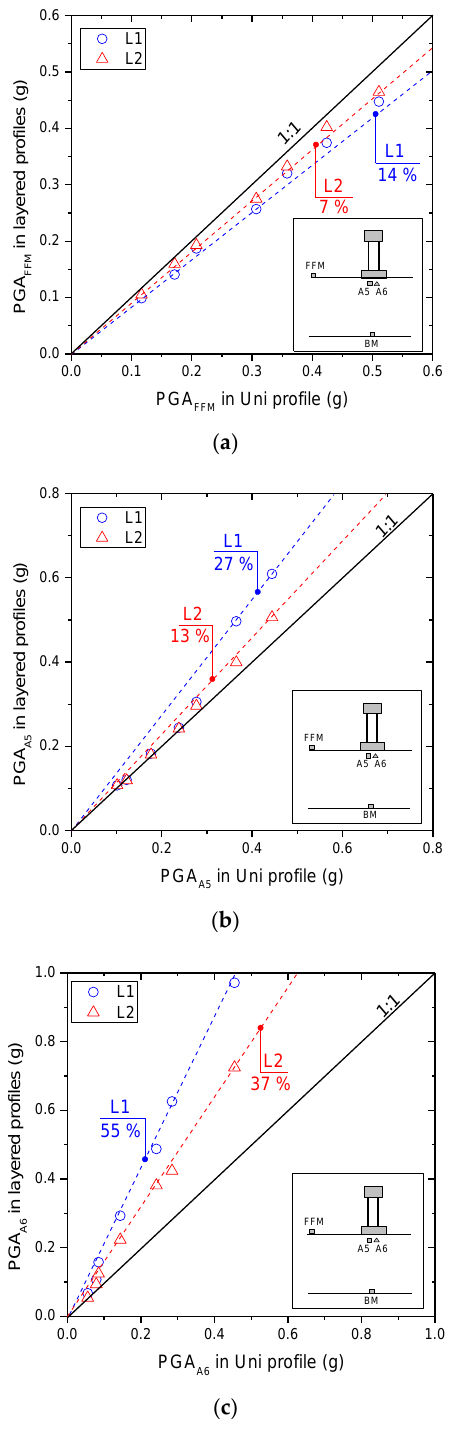
Figure 5. Comparison of ( a ) peak acceleration (PGA) FFM , ( b ) PGA A5 (horizontal motion), and ( c ) PGA A6 (vertical motion) obtained on layered profiles (i.e., L1 and L2) with those on uniform profile (Uni). The values in the figure indicate the maximum difference between the two measured data.